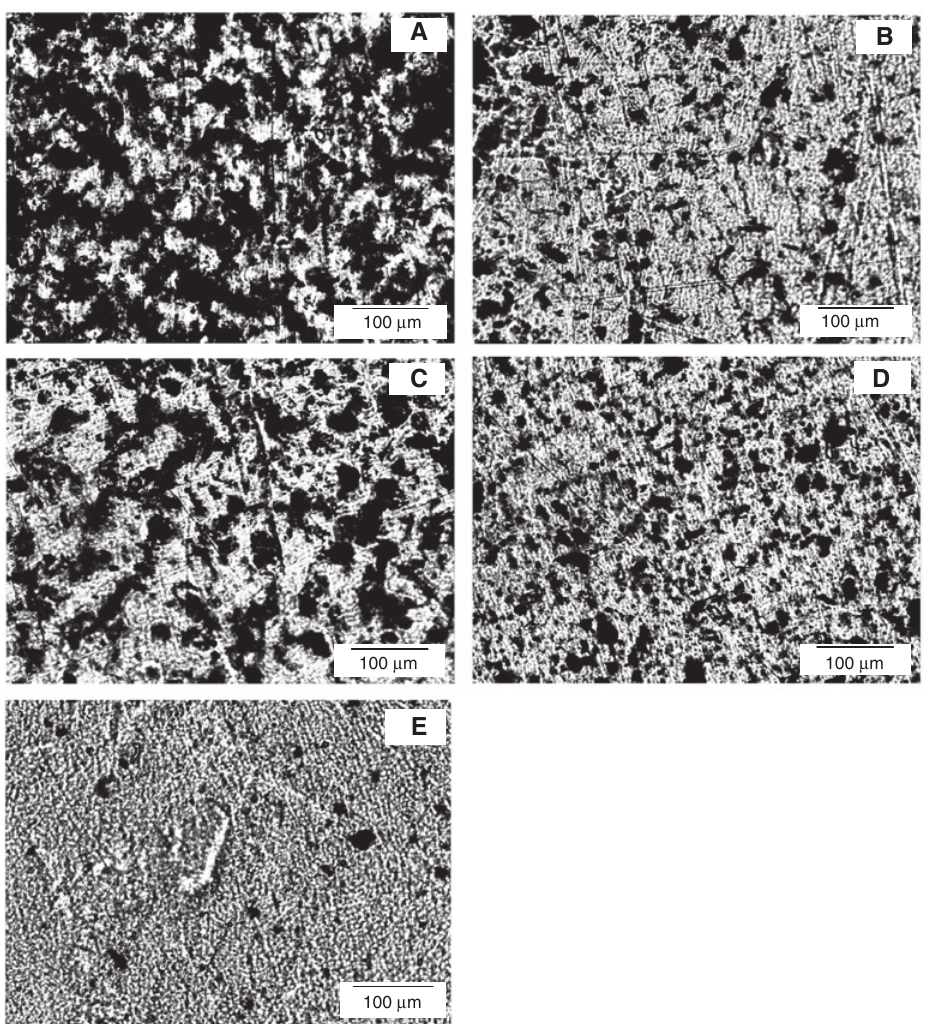
Figure 2 Optical microscopic images of the TPNR matrix containing 2 wt% (A) pristine MWCNTs, (B) acid-treated MWCNTs, (C) pristine MWCNTs-Fe O , (D) acid-treated MWCNTs-Fe 3 4